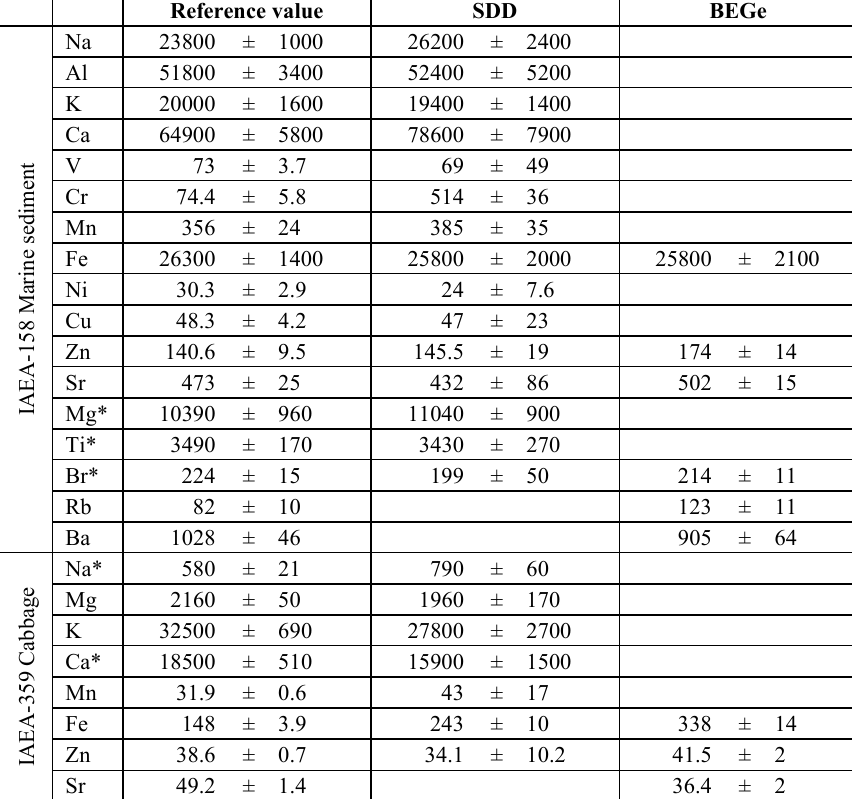
Table 1. Elemental concentrations (mg kg -1 ) with standard deviations for used reference materials Reference value SDD